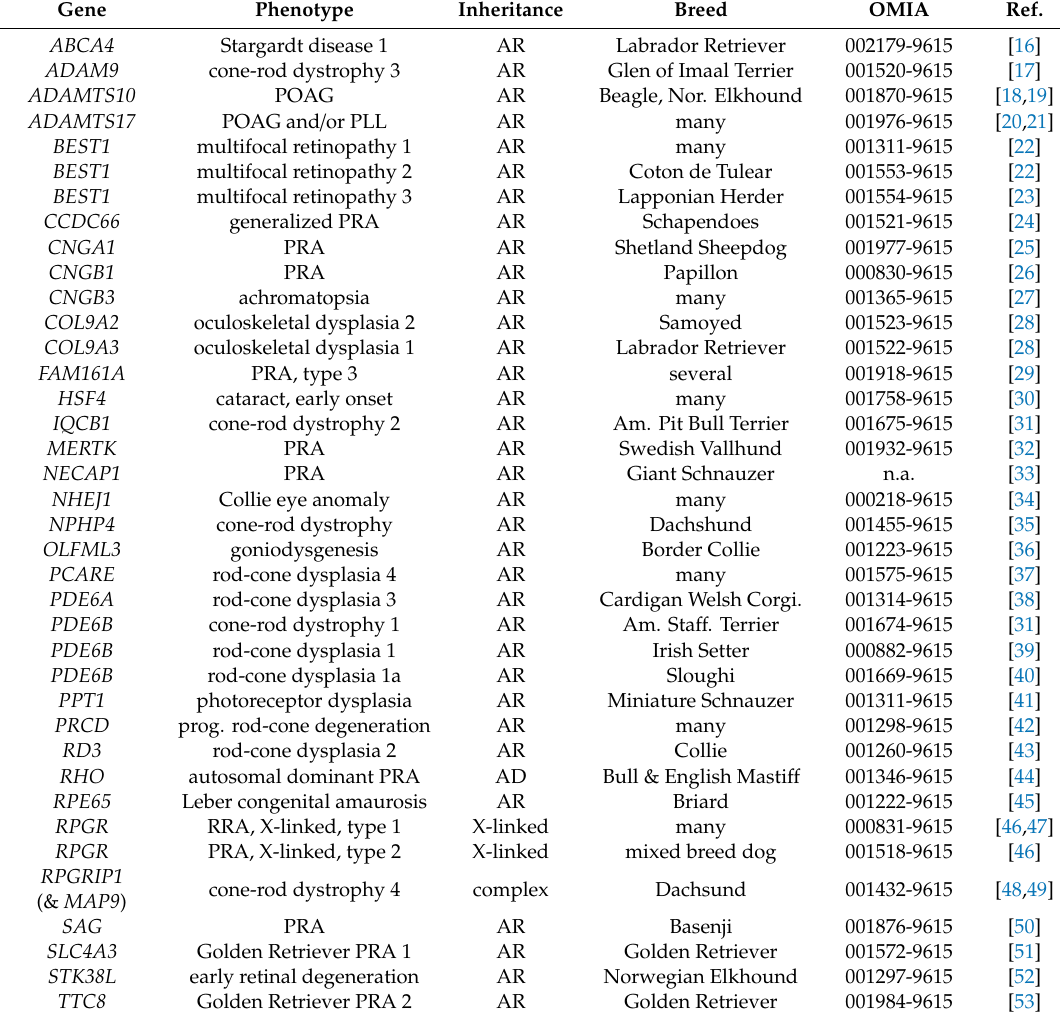
Table 1. Overview on canine inherited eye